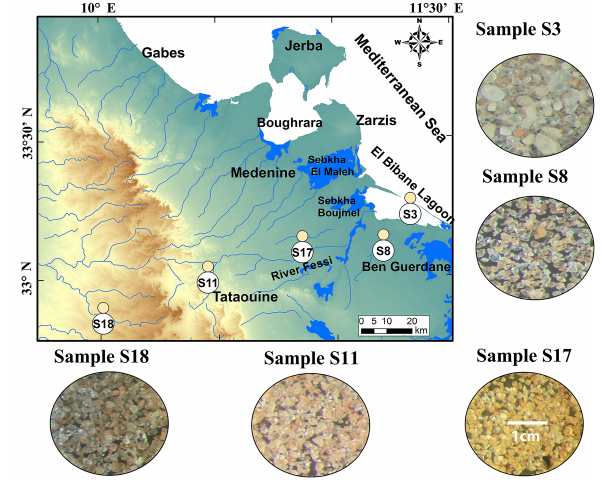
Figure 4. Microtextural photos under binocular microscope obser- vation of five representative samples from the catchment basin of El Bibane Lagoon. S3: marine sample; S8 and S11: Fessi River sam- ples; S17 and S18: dunes samples (diameter of the photos: 3cm; G ×